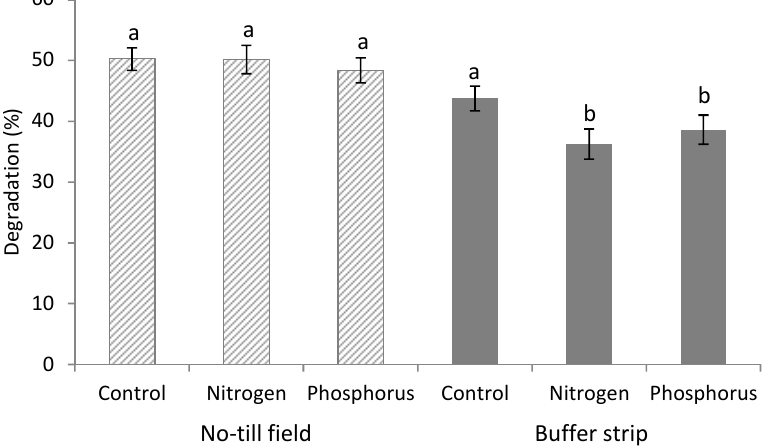
Figure 4. Degradation percentage of Fertimetro cotton threads observed in the NT field and vegetated BS. Control: untreated thread; Nitrogen: thread pre-treated with N solution; Phosphorus: thread pre-treated with P solution. Pairs of data sharing the same letter are not significantly different ( p > 0,05). Bars report the standard error.